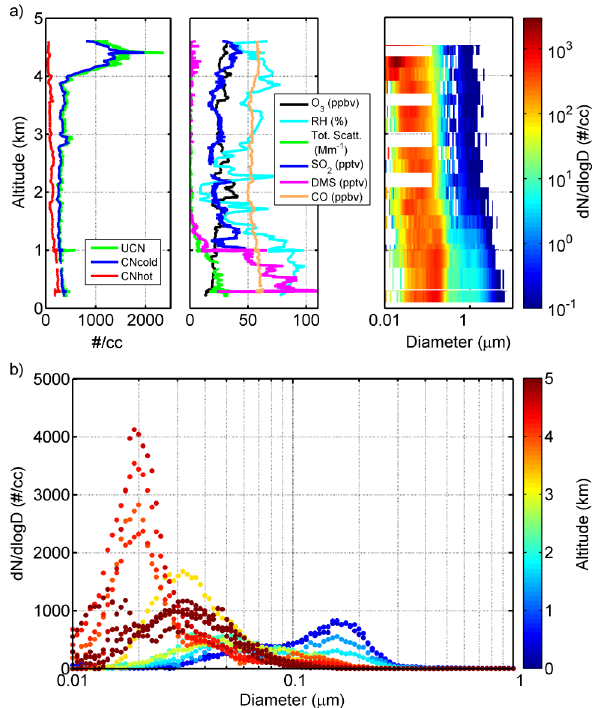
Fig. 4. (a) Example profile for RF04 cloud study. Left panel shows CNhot generally decreases with altitude and is anticorrelated with CNcold and UCN. Middle panel illustrates how the DMS maxi- mum near surface is depleted above inversion, as is total aerosol light scattering. Enhanced outflow around 4300m is associated with increases in DMS and UCN, where the increase in UCN indicates recent nucleation. Lowest values for CNhot and light scattering are most evident at this altitude range, indicating greatest scavenging where CO is close to surface values (see text for details). Right panel reveals concurrent associated 2-D size distributions color coded with concentration. (b) Distributions from a second nearby profile include those above (brown) and below (yellow) the outflow layer (orange-red). The outflow nuclei peak at 0.02µm extends down be- low 0.01µm, while MBL distributions (blue) show negligible CN present below